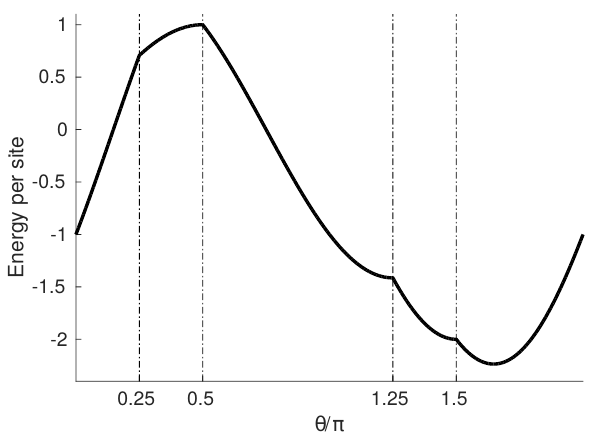
Figure 5: The product ground state energy. The kinks in the energy per site suggest that the phase transitions at the SU(3)-symmetric points are of first order.